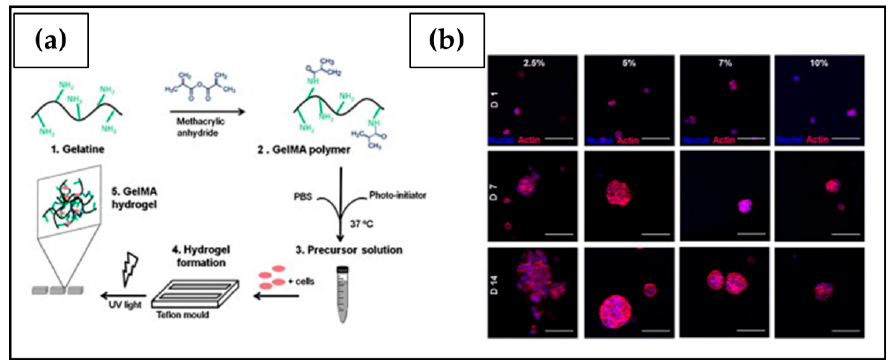
Figure 13. Gelatin–methacryloyl (GelMA) hydrogels. ( a ) GelMA-based hydrogel preparation: gelatin (1) and methacrylic anhydride reacted to form GelMA (2); GelMA is dissolved in PBS at 37 °C and mixed with the photoinitiator and cells (3); the cross-linking reaction is induced by UV light (4); the hydrogel is cut into smaller units (5). ( b ) Representative confocal laser scanning microscopy mi- crographs of cells embedded within GelMA hydrogels obtained from various polymer concentrations ( w / v ) and relevant stiffness (2.5%, 0.7 kPa; 5%, 3.4 kPa; 7%, 7.3 kPa and 10%, 16.5 kPa); nuclei are stained in blue and actin cytoskeleton in red (scale bars, 100 µ m)